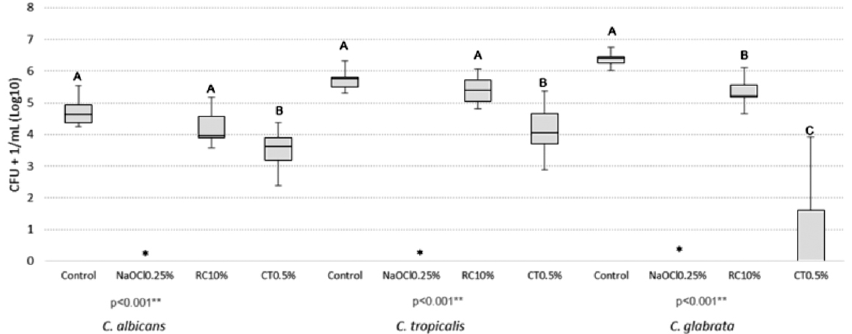
Figure 1- Comparative analysis of microbial load (CFU + 1/ mL, log10) of Candida spp. after immersion of the specimens in the disinfectant and control